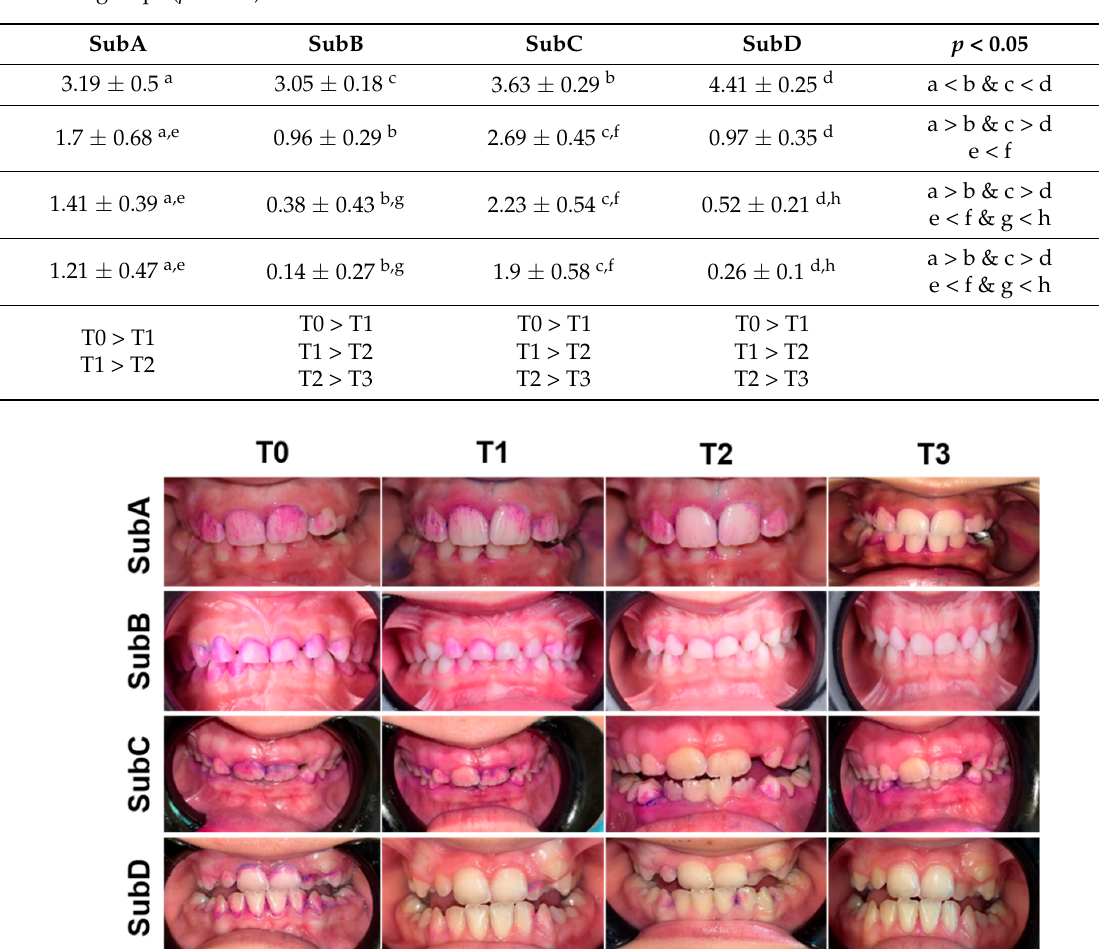
Table 3. Mean and standard deviations for each score of plaque accumulation at the different periods for SubA: Children with no special needs who used a conventional toothbrush; SubB: Children with no special needs who used a customized handle toothbrush; SubC: Children with Down syndrome who used a conventional toothbrush; SubD: Children with Down syndrome who used a customized handle toothbrush. Upper letters ( a–h ) indicate statistically significant differences (raw) between the different subgroups ( p < 0.05).